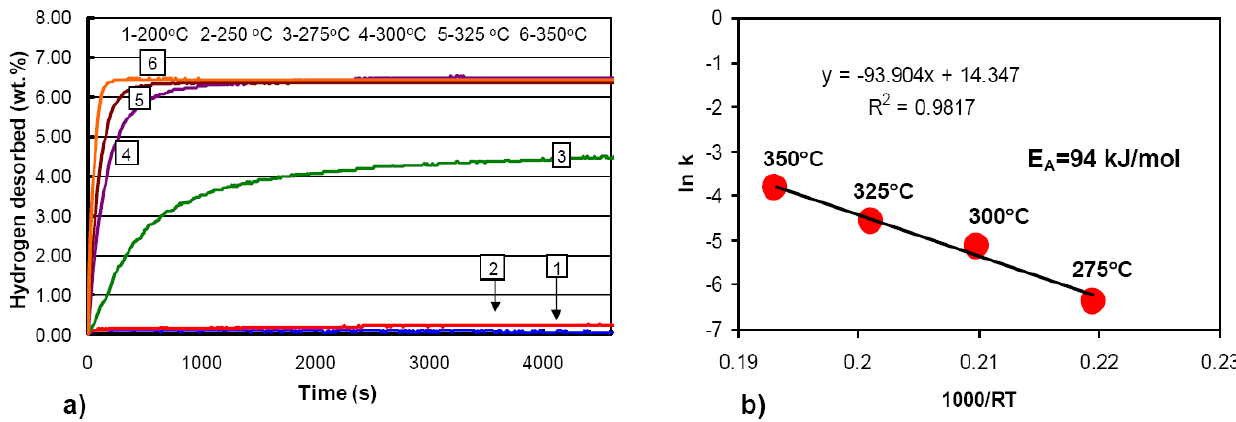
Figure 8. (a) Volumetric hydrogen desorption curves at various temperatures under initial hydrogen pressure of 0.1 MPa for the MgH + 5 wt.% n-Ni nanocomposite directly after 2 milling for 15 min (average ECD = 0.74 ± 0.46 μm). (b) The Arrhenius plot of the desorption rate for the estimation of the apparent activation energy, E . Adapted from A